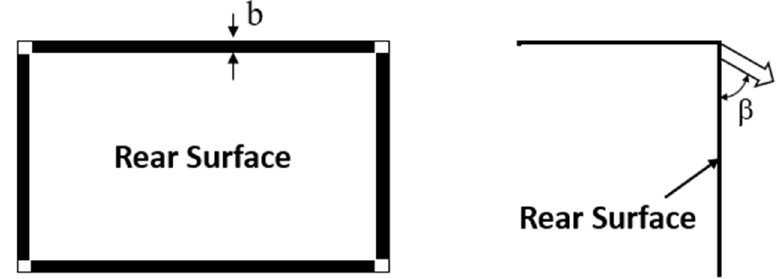
Figure 7. Schematic of a control device setup.